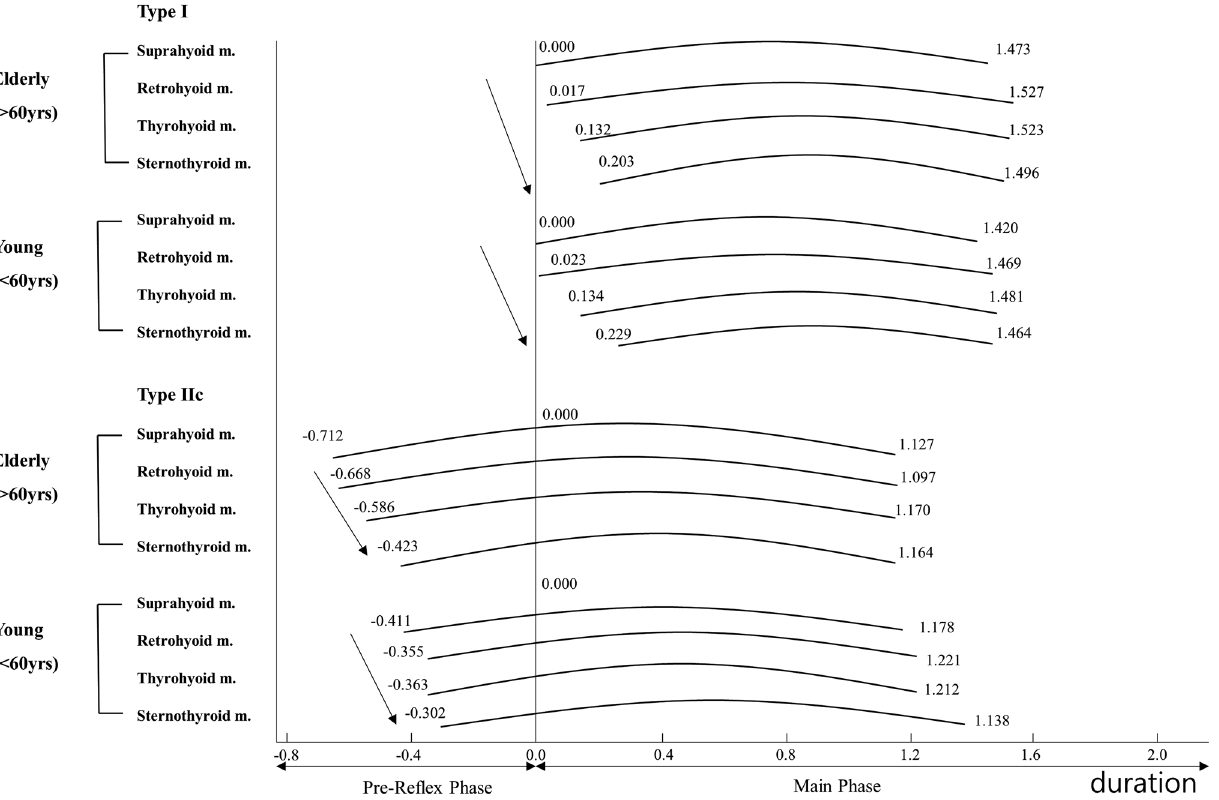
Figure 4. The activation sequence of oropharyngeal muscles during 5 cc water swallowing. S-EMG revealed that the activation sequence was in the order of the suprahyoid (SH), retrohyoid (RH), thyrohyoid (TH), and sternothyroid (StH) muscles in both the young and older